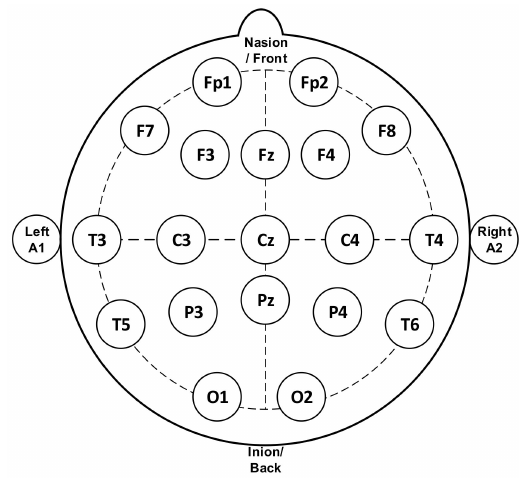
Figure 1. Electrodes placement of electroencephalogram (EEG) measurement [4] (reproduced with permission by Elsevier (License Number 4781771458692)).